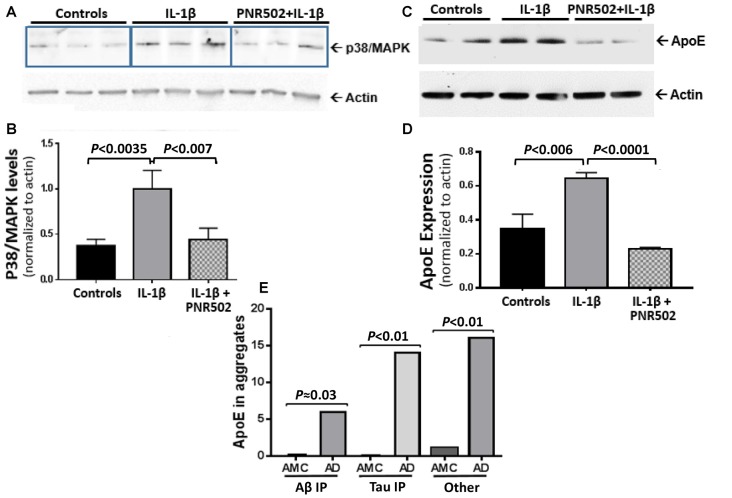
PNR502 blocks IL-1β-mediated increases in p38/MAPK and ApoE expression. (A,B) Primary neuronal cells, treated with IL-1β (30 ng/ml) in vitro, showed increased expression of p38/MAPK (quantified with antibody to the active form of p38/MAPK), but this response was blocked by pretreatment with 10-nM PNR502. The results are summarized in (B), showing means ± SD from three independent experiments, each comprising triplicate wells (as in A) and combined for statistical analysis by 2-tailed heteroscedastic t-test. (C) ApoE is induced by IL-1β treatment of NT2 cells (16 h, 30 ng/ml), but blocked if they are concurrently exposed to 10-nM PNR502; results, summarized in (D), show means ± SD from three independent experiments, each performed in duplicate. (E) Aβ1–42- and tau-containing aggregates were isolated by immuno-pulldown (IP) as described previously (Ayyadevara et al., 2016b). These two aggregate types, and total aggregates (without IP) were resuspended in buffer containing 1% (w/v) sarcosyl, pelleted by high-speed centrifugation, recovered and analyzed by proteomics as described (Ayyadevara et al., 2016b). ApoE was roughly quantified in hippocampal aggregates from AD or controls (AMC), based on spectral hits (mean ± SEM) for four samples per group.